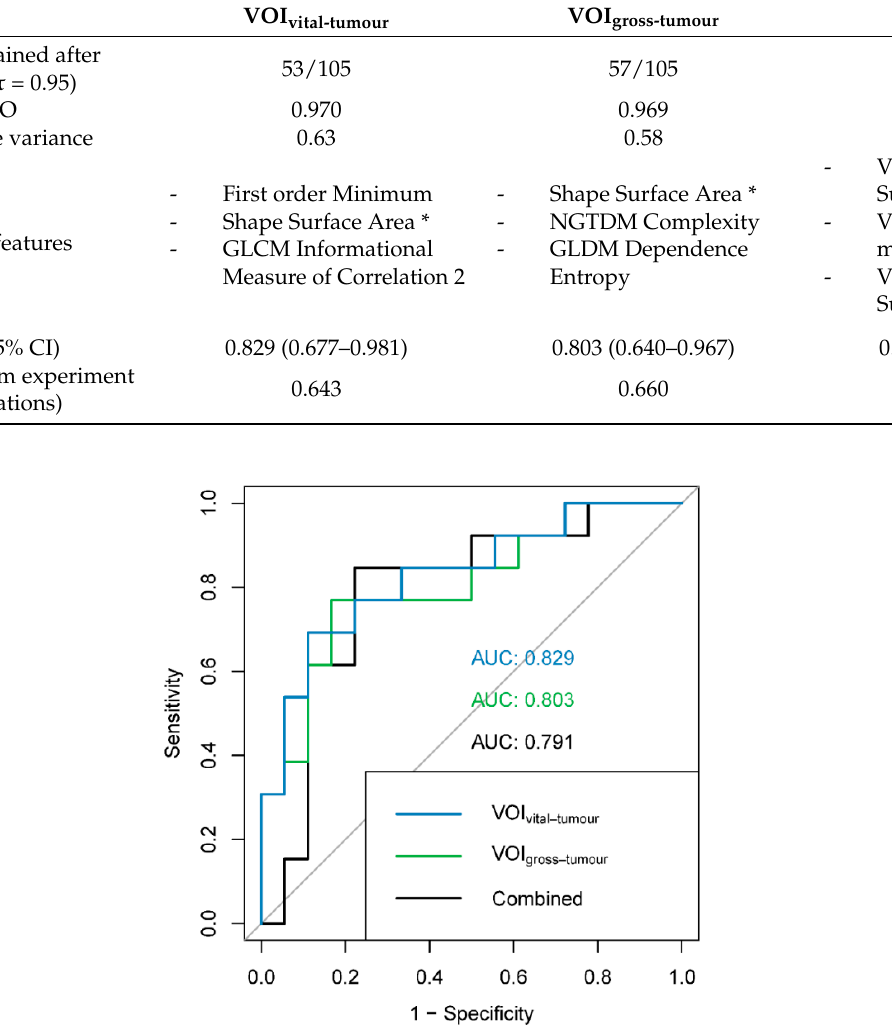
Figure 3. ROC curves and AUCs for the different radiomic models: blue: VOI vital-tumour (features: first order minimum, shape surface area and GLCM informational measure of correlation 2); green: VOI gross-tumour (features: shape surface area, NGTDM complexity and GLDM dependence entropy); black: combined (features: VOI gross-tumour GLCM sum entropy, VOI vital-tumour shape maximum 3D diameter and VOI vital-tumour shape surface volume ratio). ROC: receiver operating characteristic, AUC: area under the ROC curve. Table 5. Results of dimension reduction and predictive performance of the VOI vital-tumour , VOI gross-tumour and combined model for the noradrenergic biochemical profile in the PPGL cohort. For each model, 3 features were selected corresponding to the factors with the highest loadings. AUCs of the radiomic models and the mean AUC of the sham experiment are reported. Features marked with * are not significantly different between delineation methods in the PPGL dataset. KMO: Kaiser–Meier–Olkin (KMO) measure, AUC: area under the receiver operating characteristic curve. VOI vital-tumour